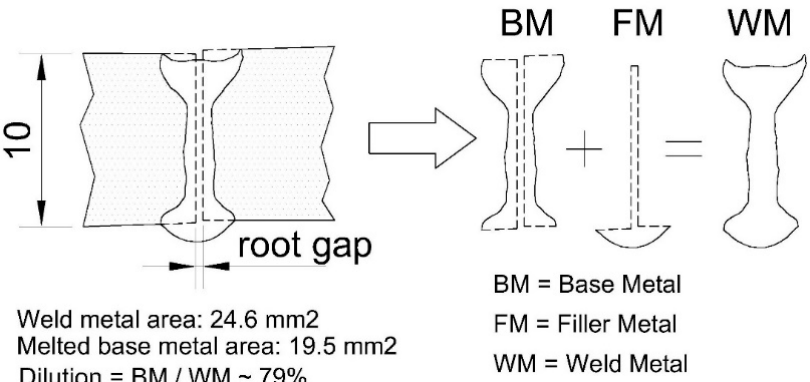
Figure 6. Example showing the cross-sectional area defined from the macrograph of test weld LAH1.